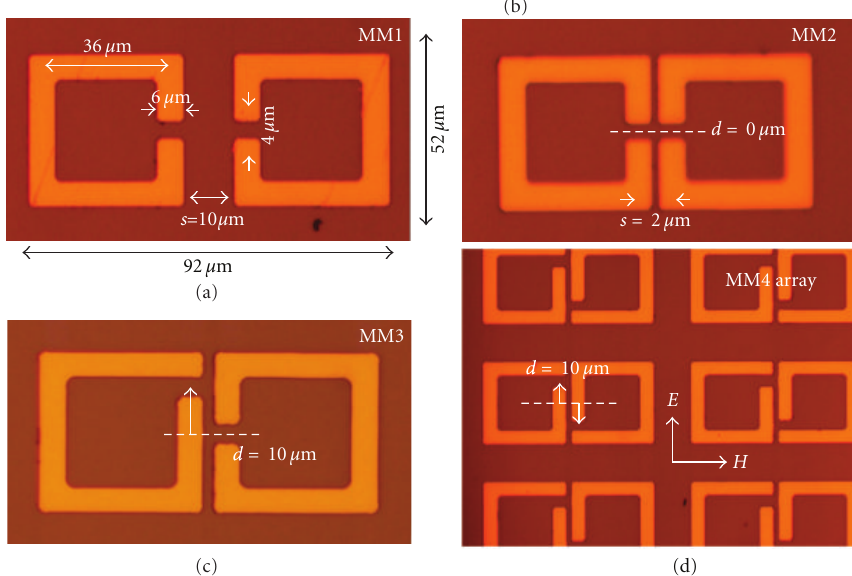
Figure 1: Optical microscope images of the fabricated metamaterial samples. (a) In the unit cell with symmetric gap-to-gap coupled SRRs, the separation is either (a) 10 μ m (MM1) or (b) 2 μ m (MM2). (c) The asymmetric SRRs with one gap displaced from the center (MM3) and (d) the SRR array where both gaps are displaced in the opposite direction from the center (MM4). The dimensions of the unit cells and their features are indicated in the figure. The unit cell periodicity for all the metamaterial samples is identical.